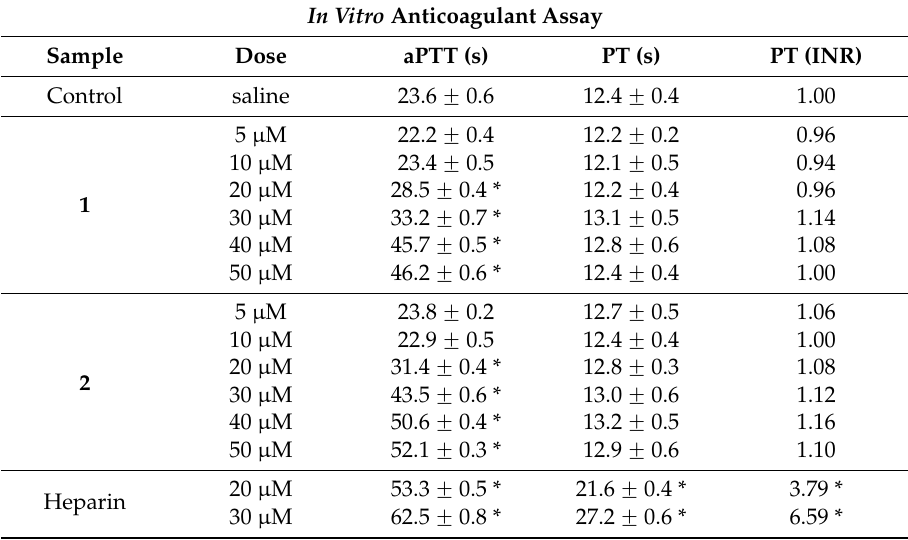
Table 2. Anticoagulant activity 1 and 2